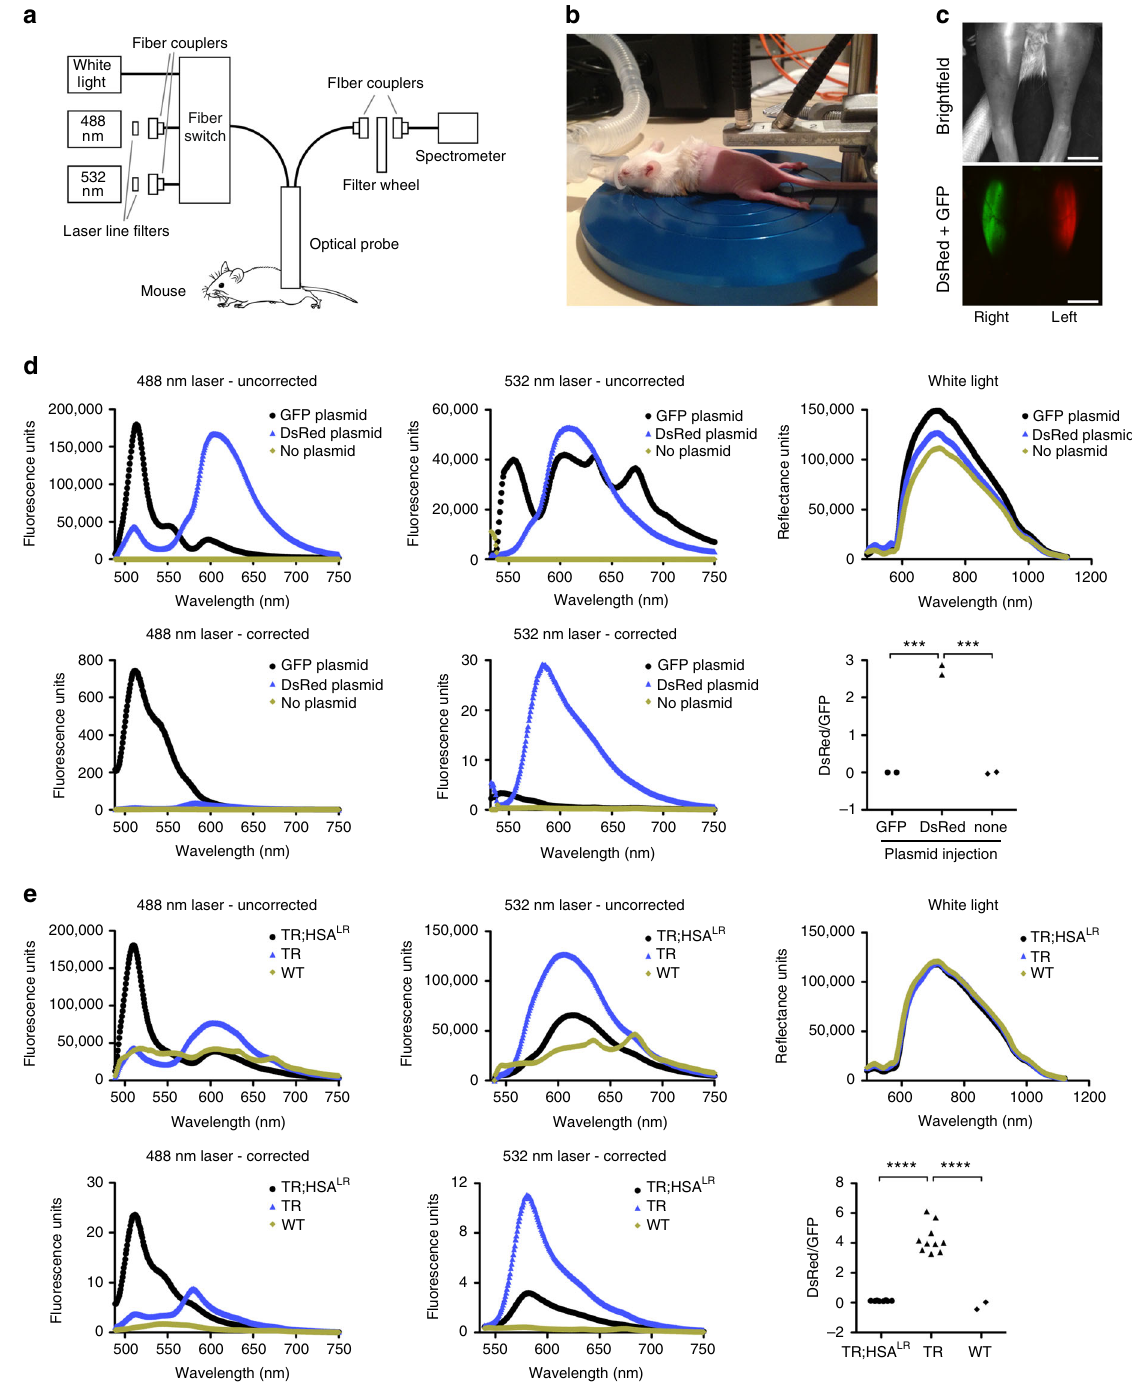
HSA promoter 14 that was used for expression of the TR transgene (Fig. 4c; Supplementary Fig. 5). Spectral scans of each injected TA muscle using 488 nm laser, 532 nm laser, white light, and background measurements, without laser power correction, were obtained sequentially using custom LabVIEW software. Auto- mated removal of background and auto fl uorescence from the raw data, and correction for re fl ectance and laser power, enabled precise determination of GFP and DsRed spectra (Fig. 4d). DsRed/GFP values were determined automatically by dividing the fi tted spectral amplitude of corrected DsRed fl uorescence using the 532 nm laser by the corrected GFP fl uorescence using the 488